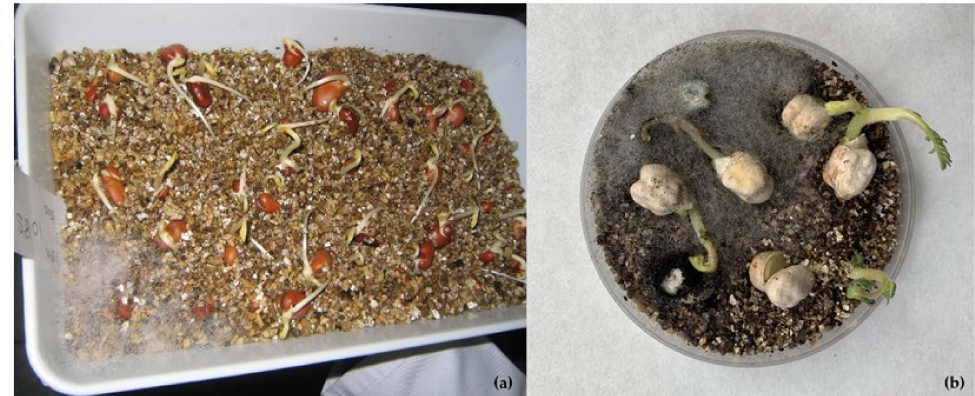
Figure 3. Germination test in vermiculite substrate. Fungi growth remains localized around the dead tissues: ( a ) bean seeds with growth of Rhizopus ; ( b ) chickpea seeds with growth of Rhizopus , Aspergillus, and Penicillium